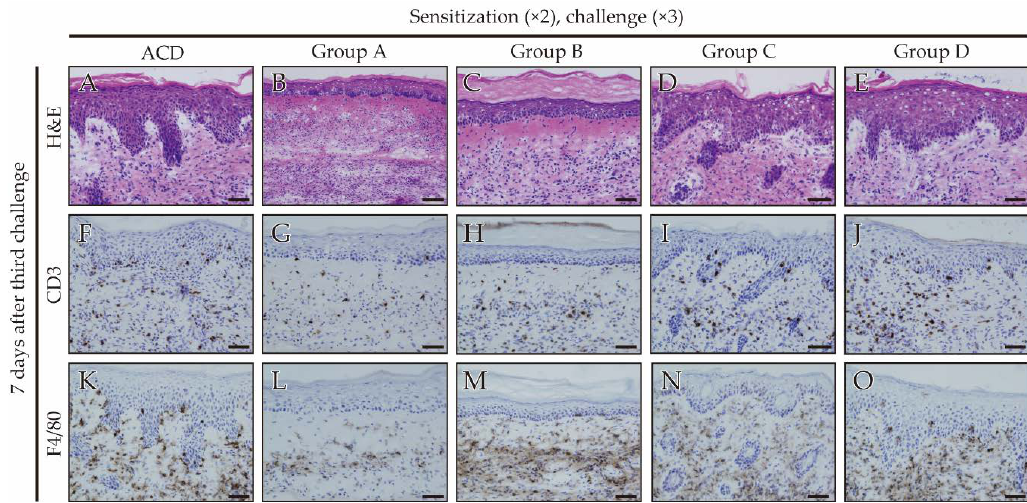
Figure 4. Histopathology and immunohistochemical analyses of accumulated T cells and antigen- presenting cells (APCs) in Pd-induced ACD mice treated with fexofenadine or prednisolone. Histopathology and immunohistochemical analyses of monoclonal antibody (mAb) that binds to a surface molecule on mature macrophages and dendritic cells (F4/80-positive cells) and cluster of differentiation (CD) 3-positive T cells in footpad tissues. Frozen footpad tissue sections were stained with hematoxylin and eosin (H&E) ( A – E ) and anti-CD3 ( F – J ) and anti-F4/80 ( K – O ) antibodies at 7 days after the last challenge. Scale bar = 100 µm. Int. J. Mol. Sci. 2017 , 18 , 1357